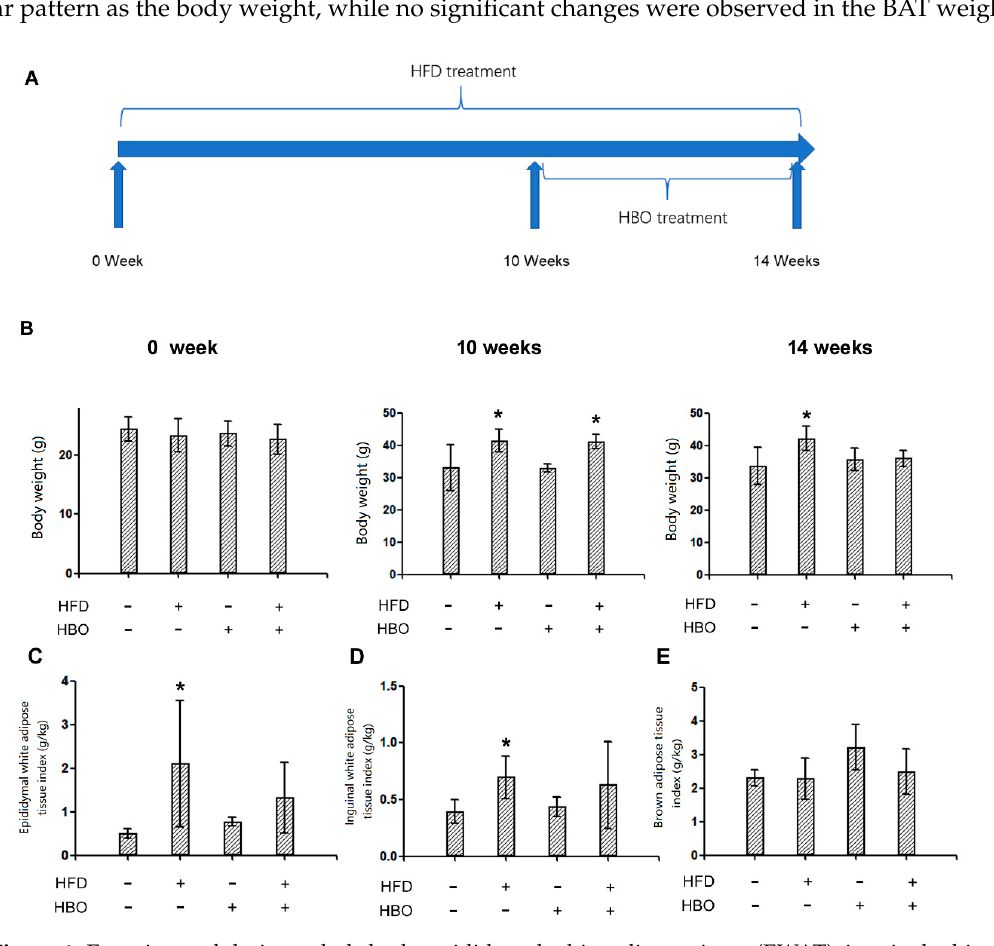
Figure 1. Experimental design, whole body, epididymal white adipose tissue (EWAT), inguinal white adipose tissue (IWAT), and brown adipose tissue (BAT) weight. C57 / B6 mice were kept in 21–25 ◦ C environment with 12 h light / dark cycle. Food and water were provided ad labium. Animals received normal chew diet, or HFD (15% lard, 3% soybean oil, 5% egg yolk, 18% sugar, and 59% chew diet) for a total of 14 weeks. HBO treatment (5 min pressure rise stage, 60 min stabilization stage with 2.0 atmospheres absolute and 100% oxygen, 5 min depression stage) were applied during the last 4 weeks of diet treatment. At the end of treatments, whole body weight was measured, then animals were sacrificed, EWAT, IWAT, BAT, and skeletal muscle were weighed and collected. Three to five animals were included in each group. Error bars represent standard derivation. ( A ): The whole experimental design. ( B ): The body weights at 0-, 10- and 14-week. ( C ): EWAT weight at the end of study. ( D ): IWAT weight at the end of study. ( E ) : BAT weight at the end of study. *: statistically di ff erent from control group animals ( p <